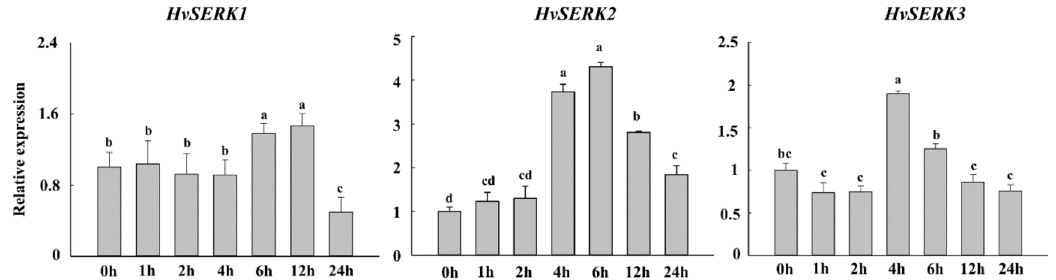
Figure 3. Expression profiles of HvSERK1/2/3 in response to Bgh infection by qRT-PCR. The actin gene was used as an internal control to normalize qRT-PCR values. Different letters indicate statistically significant differences ( p < 0.05, one-way